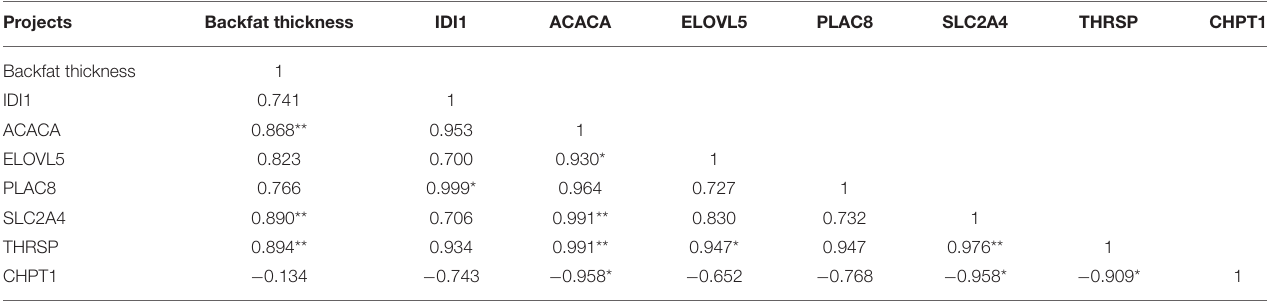
TABLE 3 | Correlation analysis between backfat thickness and various genes in Tibetan pigs.